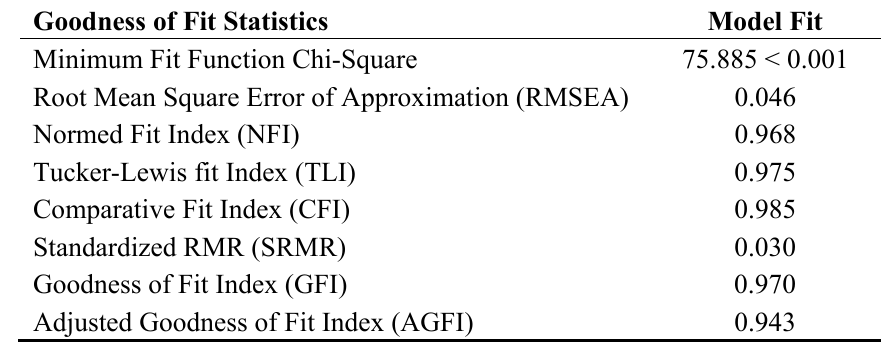
Table 2. Results of confirmatory factor analysis for the ASSET questionnaire.